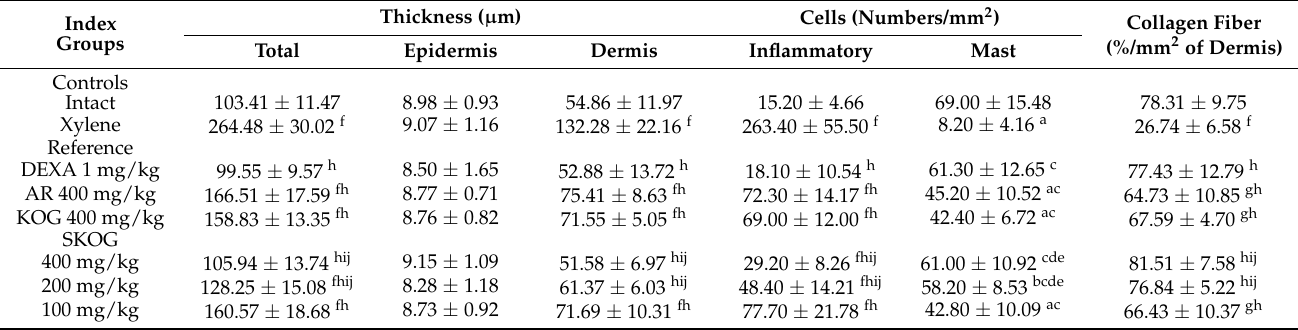
Table 3. Effects of AR, KOG, and SKOG on the histomorphometry of ear in mice.